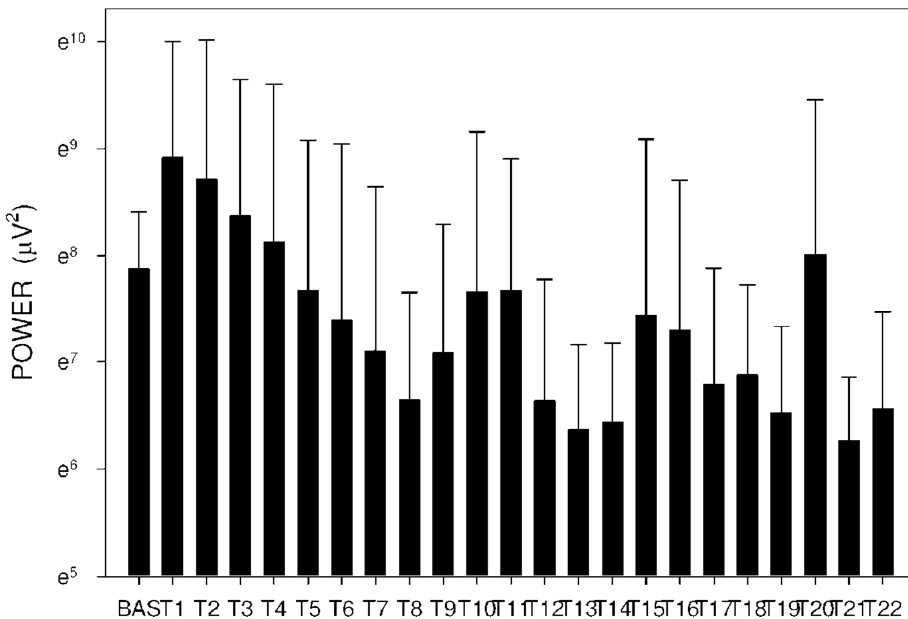
Figure 10. Electrogastrography. Dominant frequency after an intragastric administration of 10 mg donepezil (on day 8; group C) with preceding 7-day administration of donepezil (5 mg per day) and dextran sodium sulfate (10 g per day).